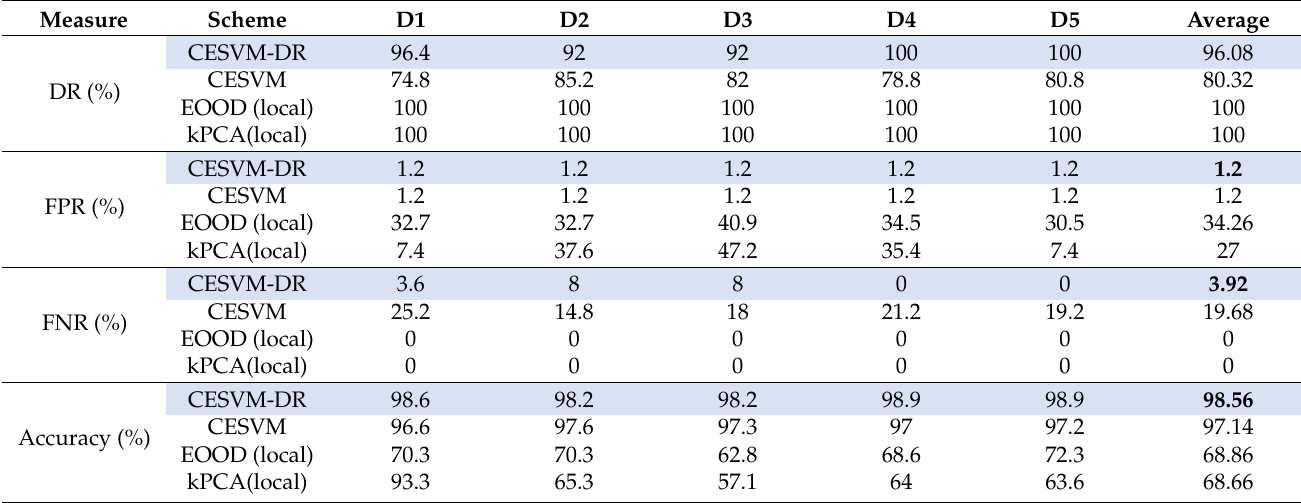
Table 2. Performance comparison between the proposed CESVM-DR scheme and related anomaly detection schemes using simulated labelling with a kernel width of 2.